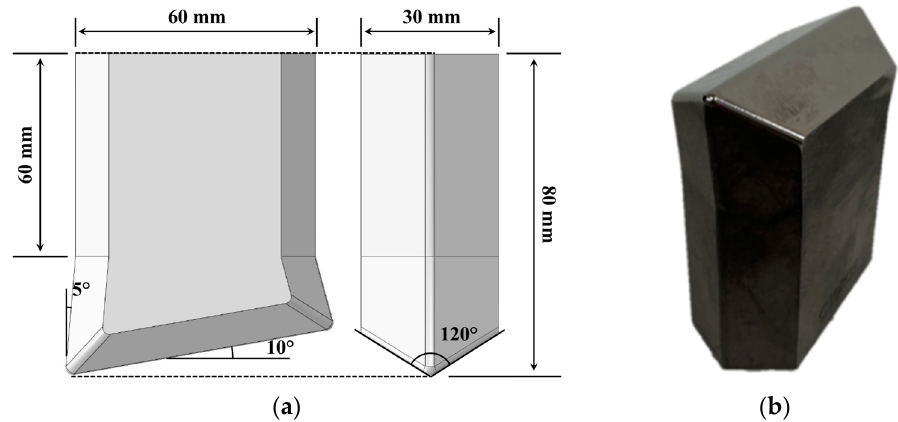
Figure 3. Cutting tool used in the experiment: ( a ) specification; ( b ) appearance.